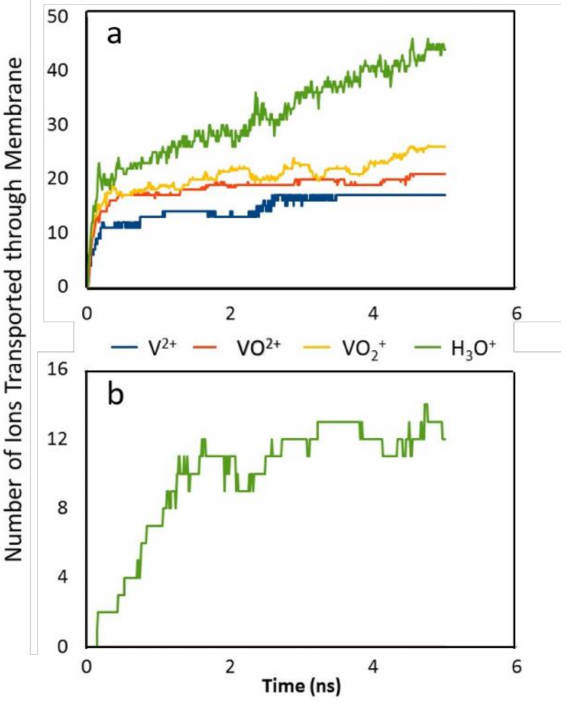
Figure 8. Ion transport events for ( a ) DON framework and ( b ) MFI framework (straight channel) at 8 mol% and 400